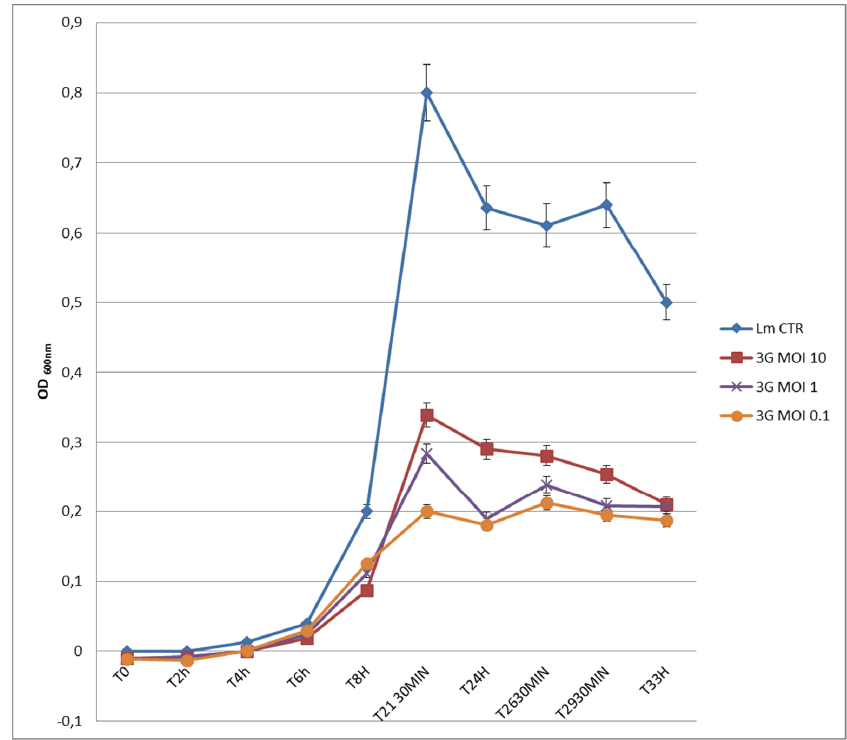
Figure 2 . Optical density values of L. monocytogenes ATCC7644 challenged with ɸ IZSAM-1 (3G) at different multiplicity of infections (MOIs) from T0 to T33h. Lm CTR: L. monocytogenes ATCC7644 untreated control; 3G MOI 10: L. monocytogenes ATCC7644 challenged with ɸ IZSAM-1 MOI 10; 3G MOI 1: L. monocytogenes ATCC7644 challenged with ɸ IZSAM-1 MOI 1; 3G MOI 0.1: L. monocyto-